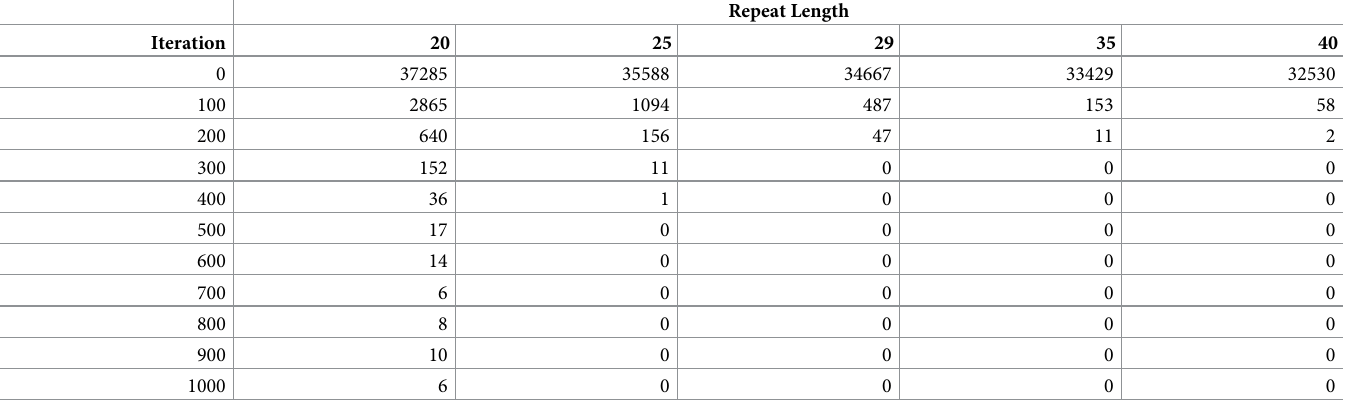
Table 2. Numbers of repeats as a function of Mason_variator iterations. The genome is E. coli . Repeats of length 20, 25, 29, 35 and 40 are columns and Mason_- variator iterations are rows.